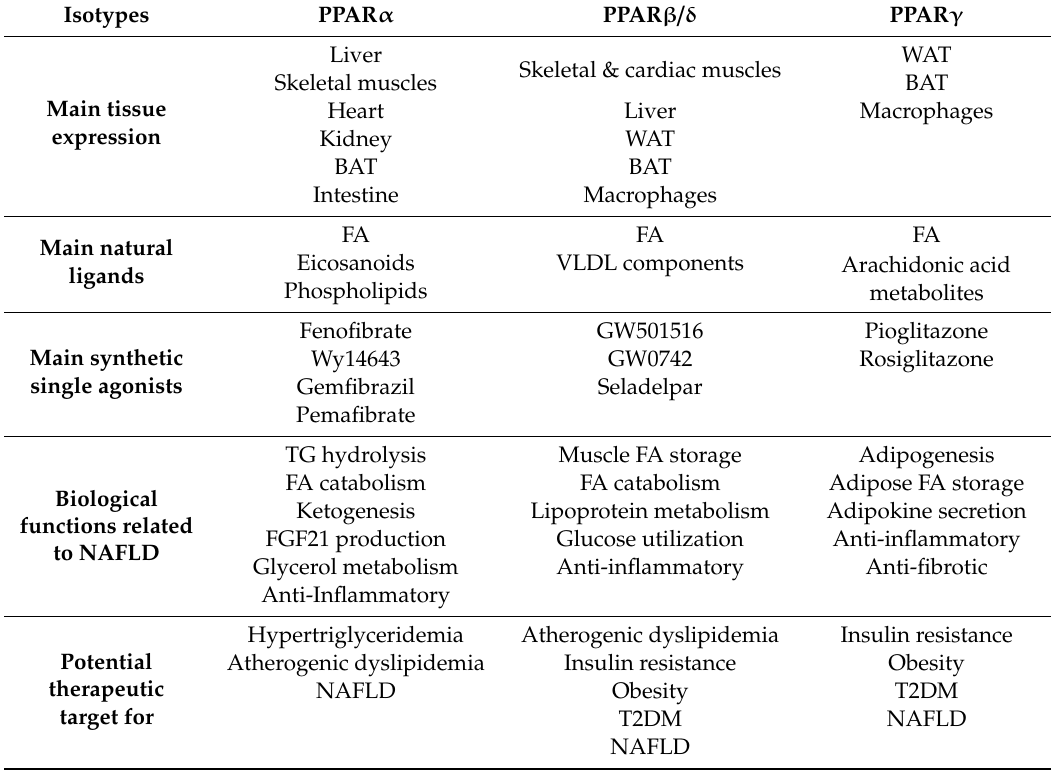
Table 1. Expression, ligands, and functions of Peroxisome proliferator-activated receptors (PPARs) related to NAFLD and therapeutic